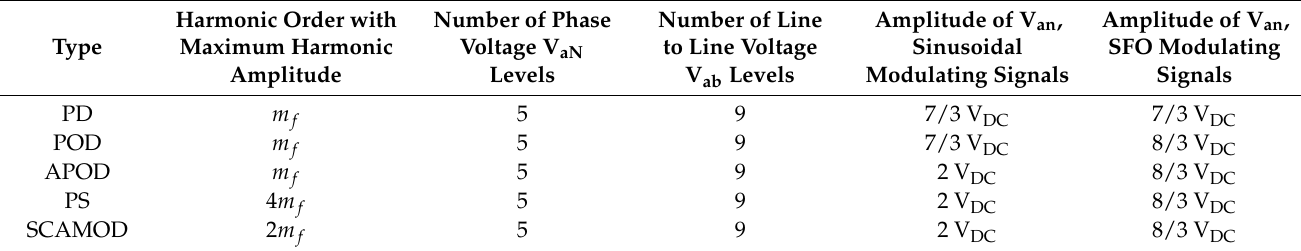
Table 6. Voltage waveform features.